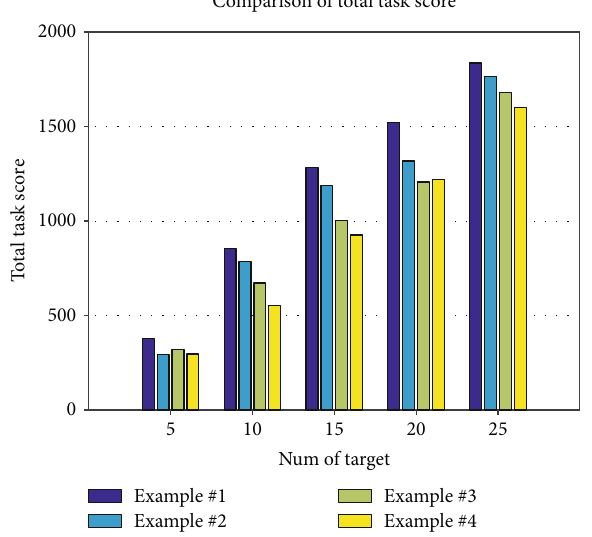
Figure 13: The comparison of total task score obtained by two types of algorithm.